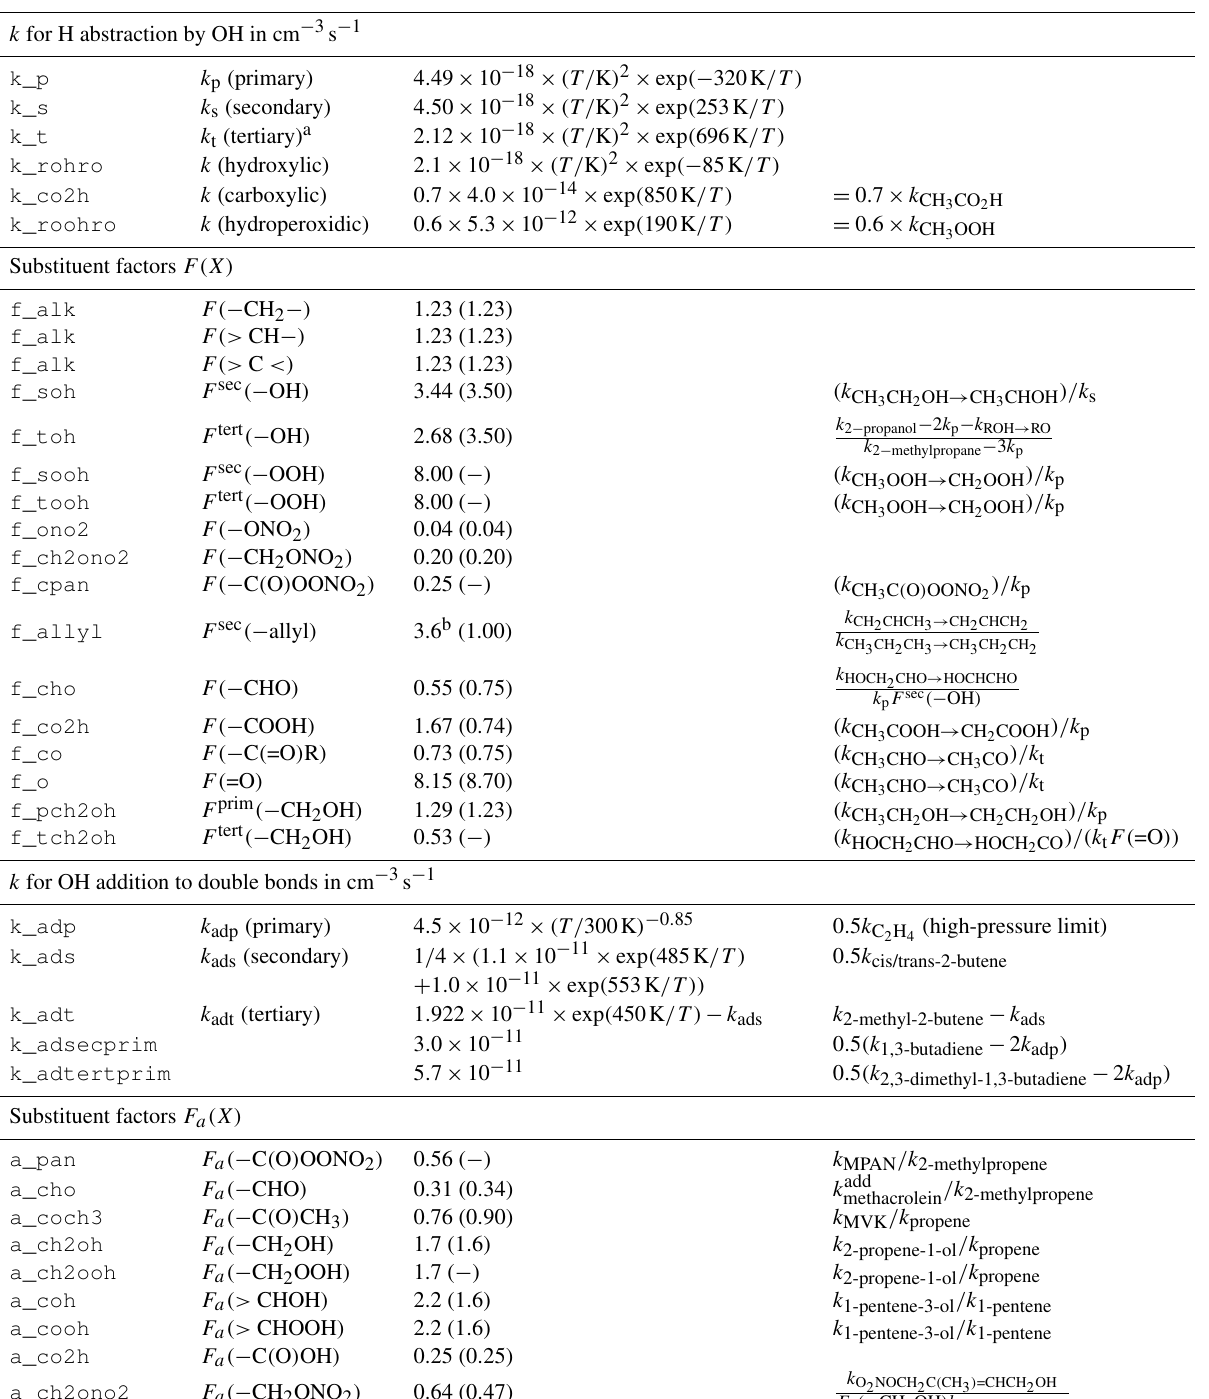
Table 1. Structure–activity relationship (SAR) parameters and substituent factors in MOM, largely based on Kwok and Atkinson (1995) for H abstraction and on Peeters et al. (2007) for OH addition, unless noted otherwise. Most base rate constants and substituent factors are updated with data from Atkinson et al. (2006). Original values for the substituent factors given by Kwok and Atkinson (1995) are listed in parentheses. All rate constants refer to reactions with